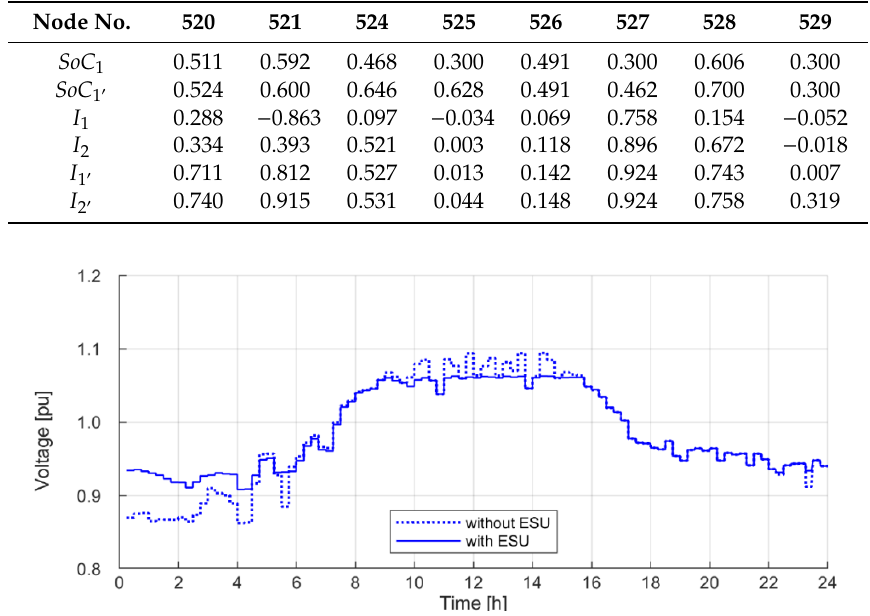
Figure 10. Daily voltage variations in node 522 (profile A).